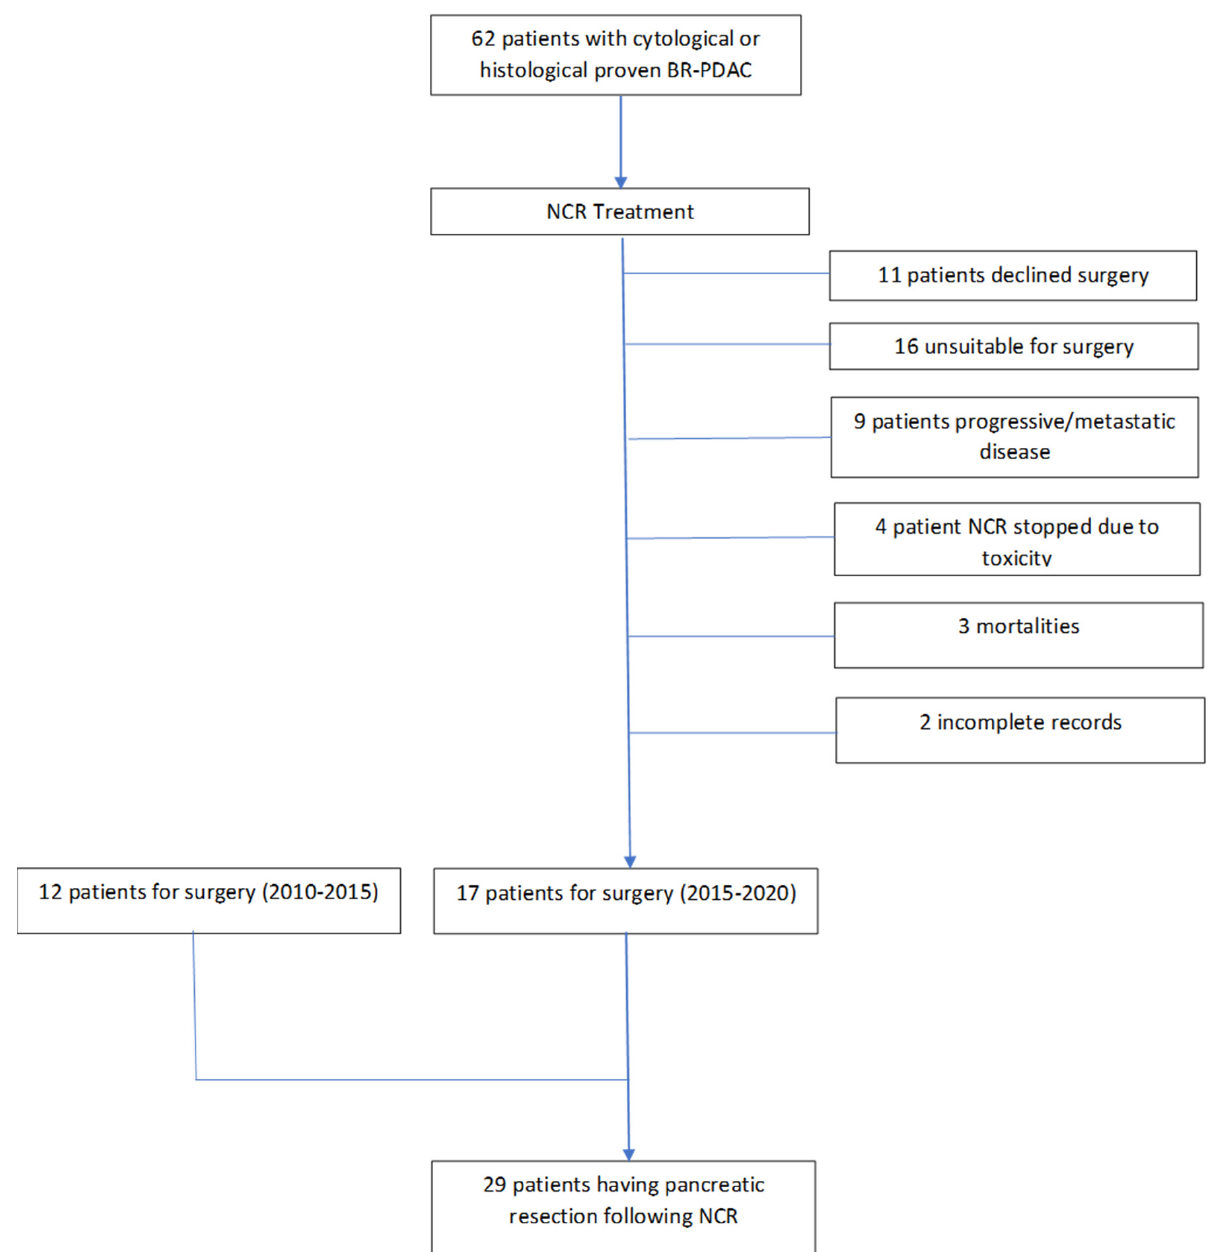
Figure 1. Flowchart depicting the patients’ cohort undergoing pancreatic resection for BR-PDAC. During NCR treatment, CA19–9 was measured at baseline at the time of diagnosis and prior to NCR treatment, at the end of NCR treatment and during follow-up after pancreatic resection. Figure 2 demonstrates the effects of NCR on serum CA19–9 levels. At baseline, patients had a mean serum CA19–9 level of 1696 IU/mL, and following NCR and prior to pancreatic resection, serum levels dropped to 69 IU/mL. The effects of recurrence on serum CA19–9 levels are discussed later.